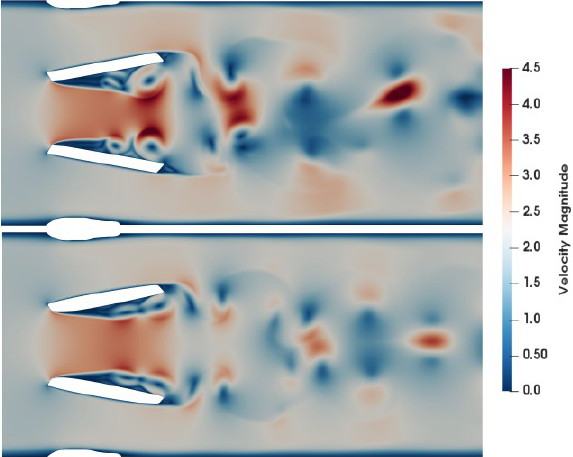
Fig. 5. Contours of velocity magnitude: original geometry (top) and final modification